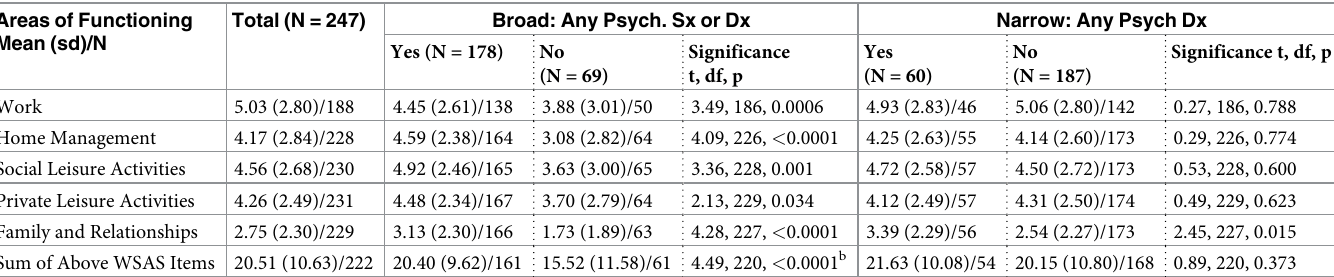
Table 2. Work and social impairment a for esds sample (N = 247). Overall Sample and By Broad and Narrow Definitions of Psychiatric Complaints at Intake. Areas of Functioning Mean